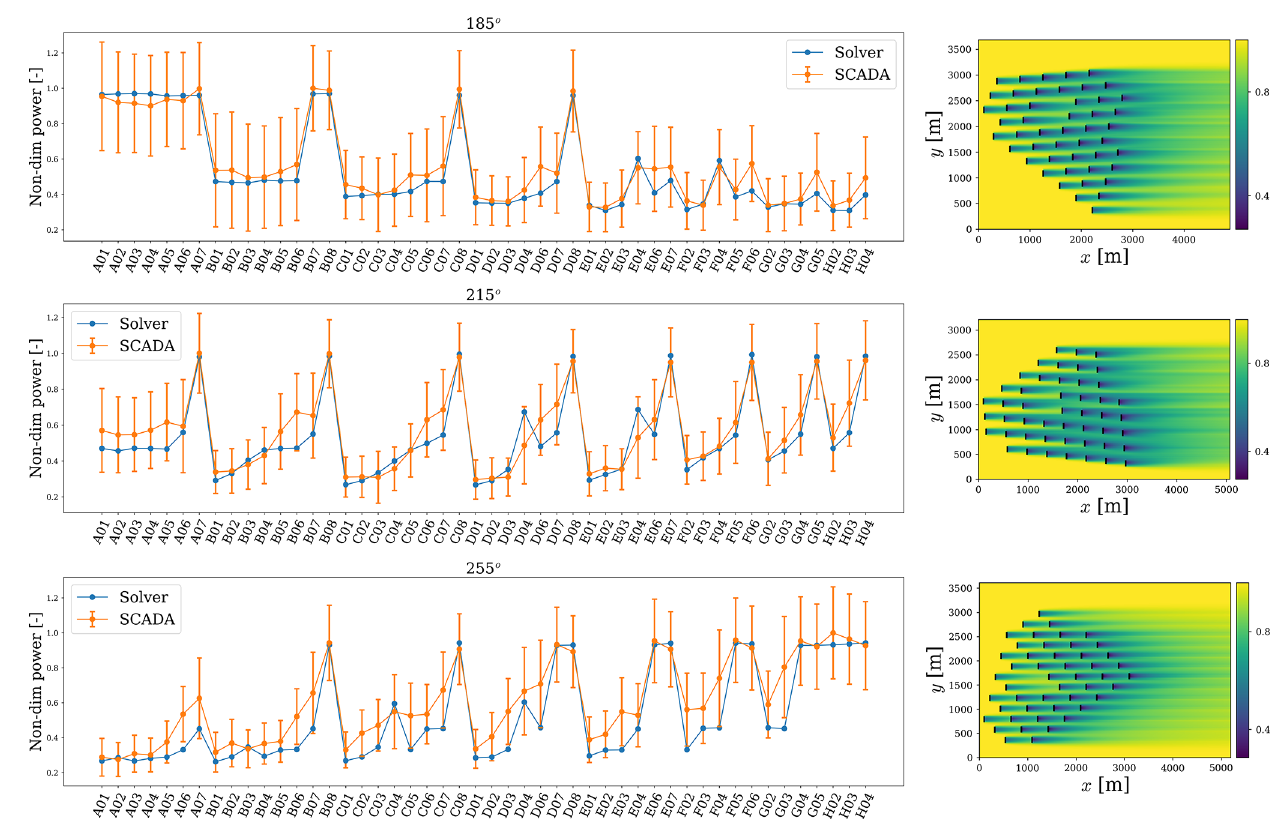
Figure 5. Comparison of turbine power versus SCADA data for the Lillgrund wind plant for cases at three different wind directions (185, 215, 255 ◦ ). Streamwise velocity contours at hub height are shown for all cases with the wind plant aligned with the flow direction. Table 1. List of LES cases performed for comparison